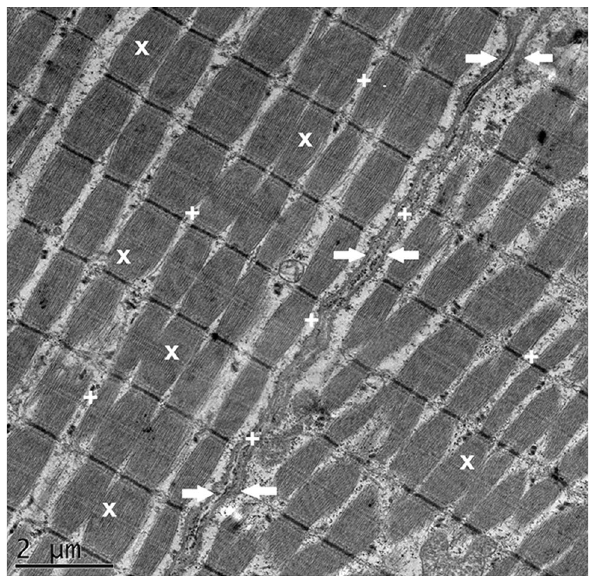
Figure 3. Control group (normal). TEM image demonstrates preserved myofibrillar structure (x), normal distance between approximating cells phospholipid membranes (arrows), intact intracellular and extracellular spaces (+).